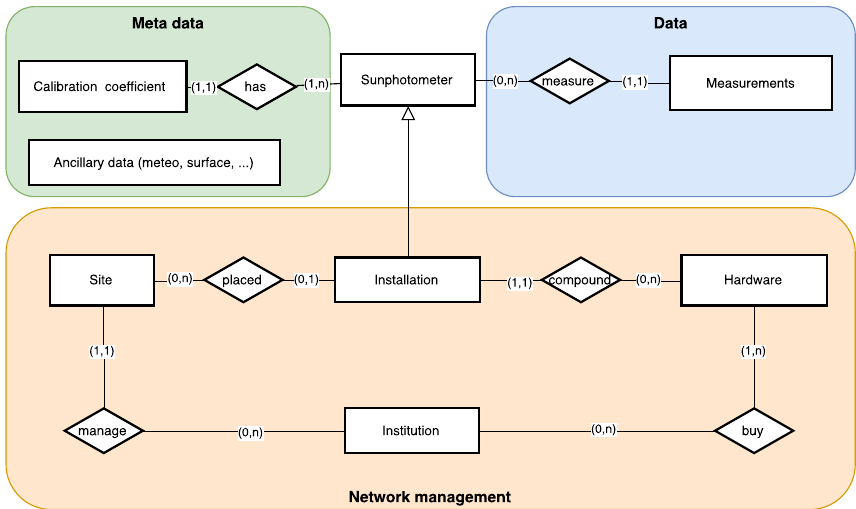
Figure 2. Entity–relationship diagram for CÆLIS (extract of the main elements). Entities have been divided into three logic blocks.